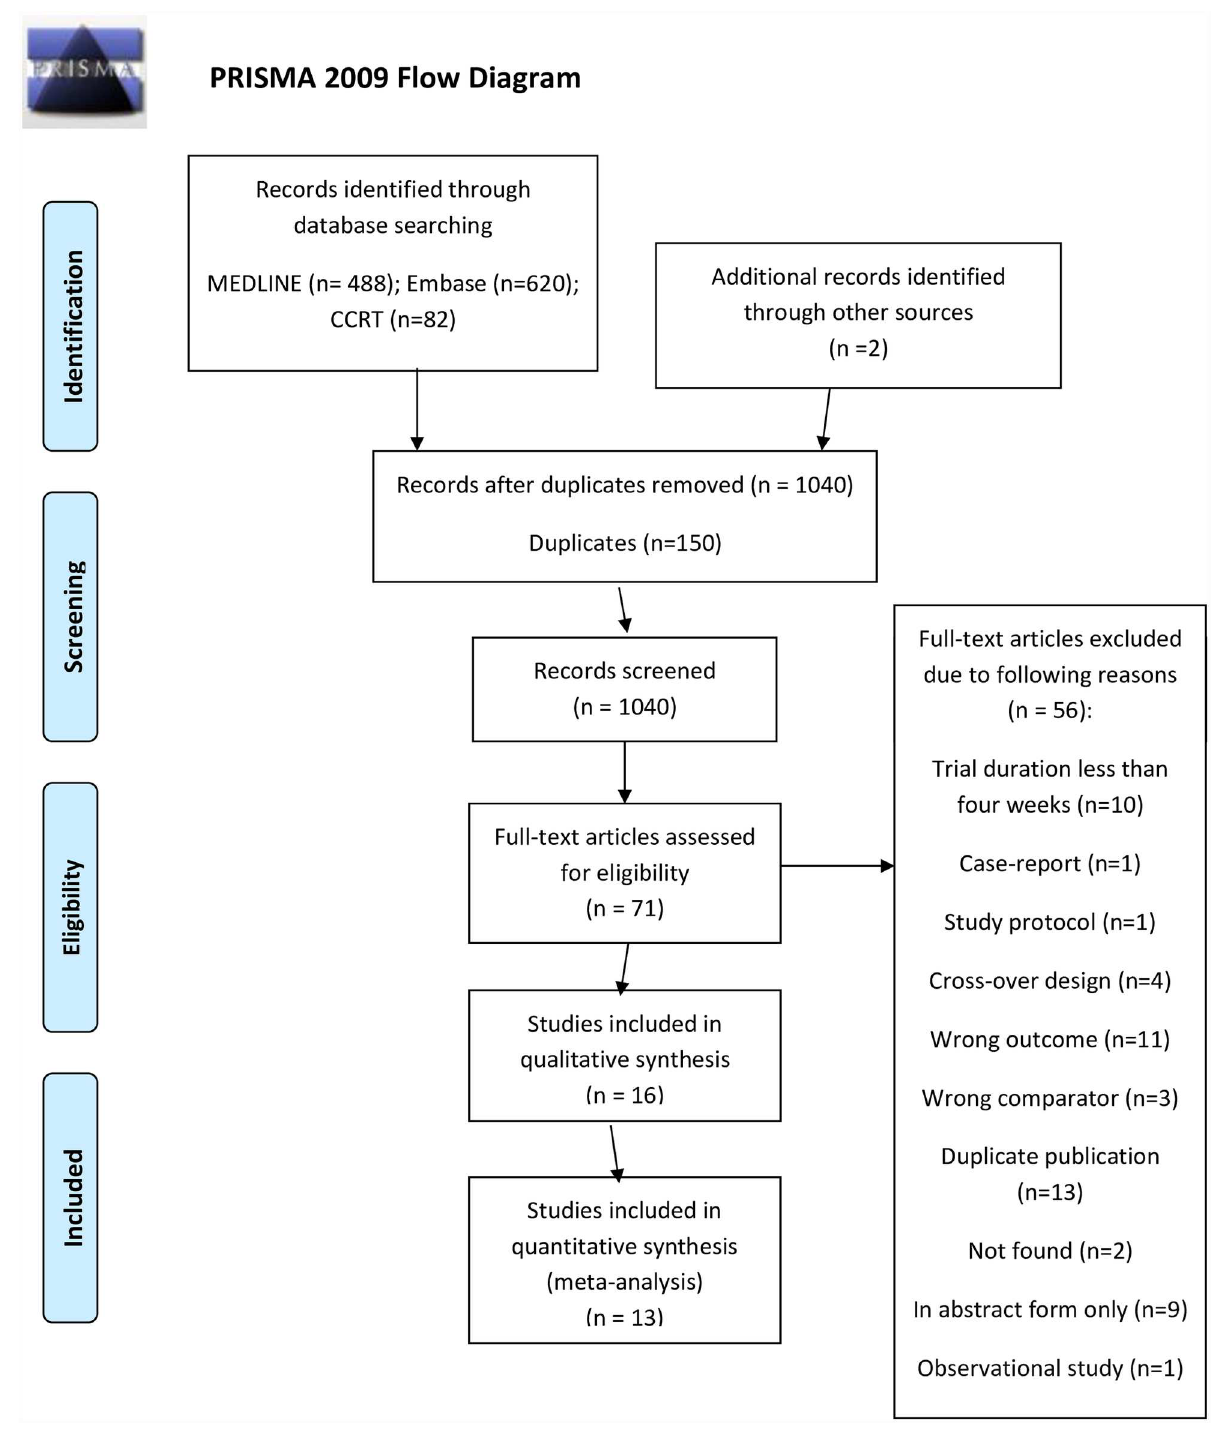
Fig 1. PRISMA flow diagram.